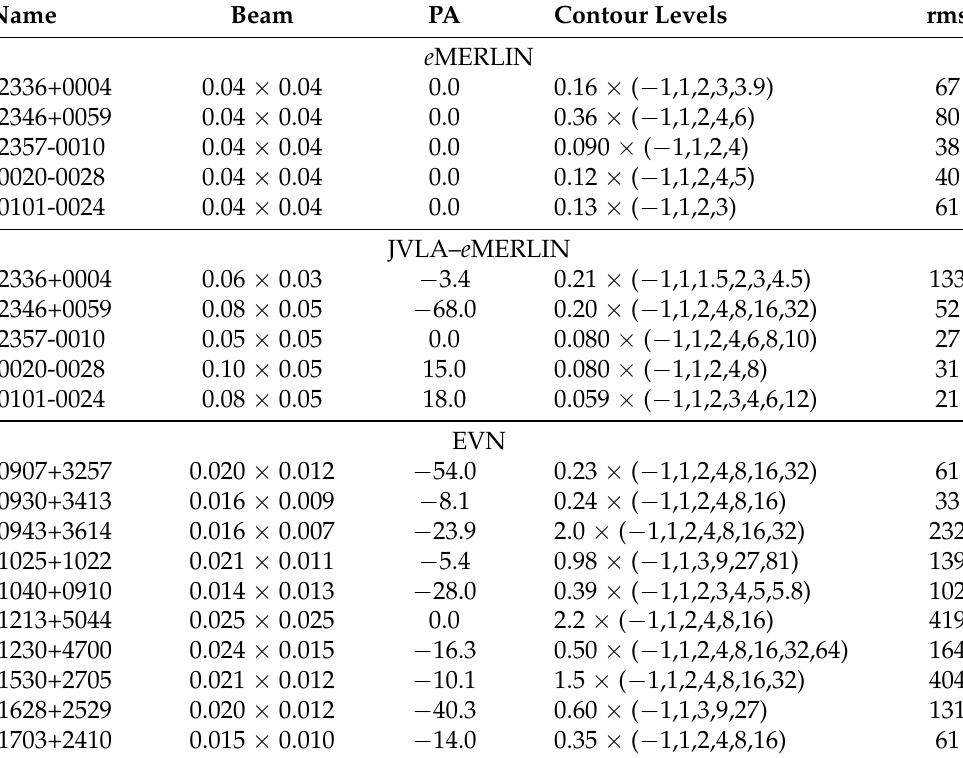
Table A1. Column description: (1) source name; (2) FWHM of the elliptical Gaussian restoring beam (in arcsec × arcsec) of the maps from e MERLIN (Figure 1), combined e MERLIN and JVLA (Figure 2), and EVN (Figure 3); (3) PA of the restoring beam (degree); (4) contour levels (mJy beam − 1 ); (5) rms level ( µ Jy beam − 1